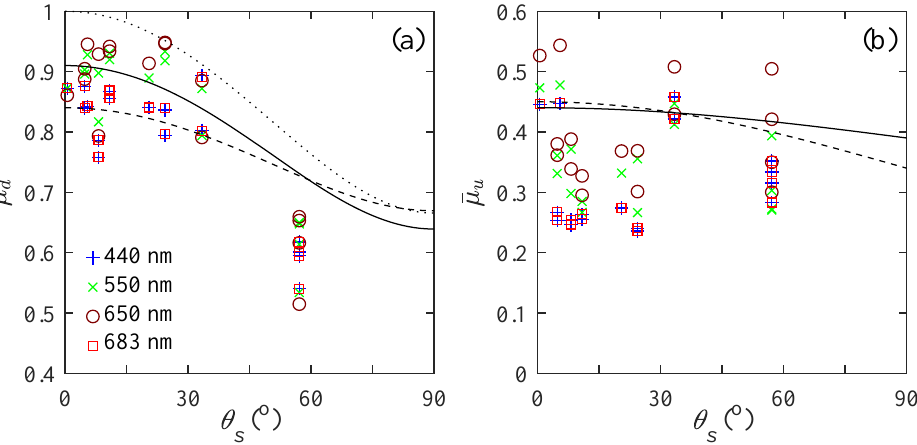
Figure 8. ( a ) Relationship between µ at selected light wavelengths as indicated and solar zenith angle d θ s . ( b ) Same as ( a ) but for µ . The presented data were collected at all stations within the top 10 m layer. u For comparison, solid lines in ( a , b ) represent the relationship reported by Lewis et al. [29] and dashed lines by Aas and Højerslev [94]. Dotted line in ( a ) represents µ = cos( θ sw ) where θ sw is the zenith angle d of the refracted solar beam just beneath the ocean surface obtained from Snell’s law.